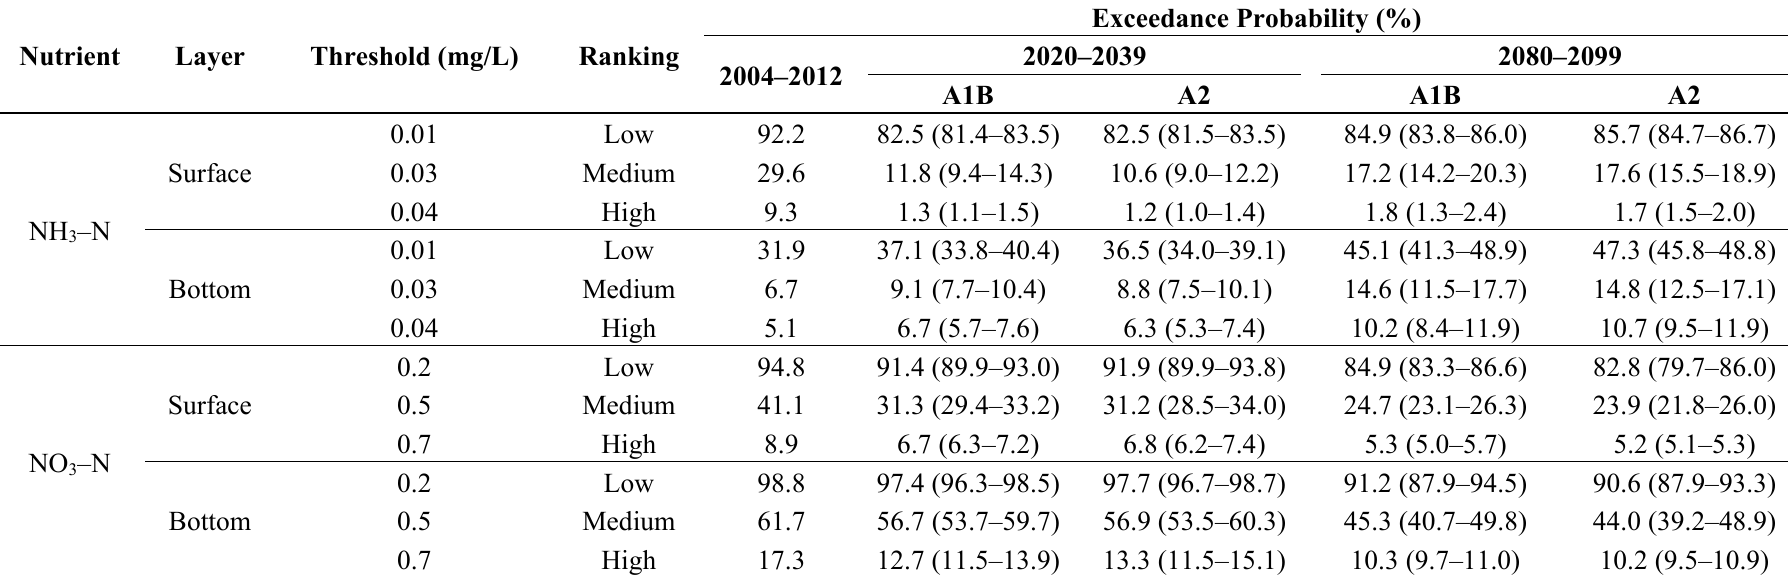
Note: The values in brackets (left to right) are confidence interval lower and upper bounds,